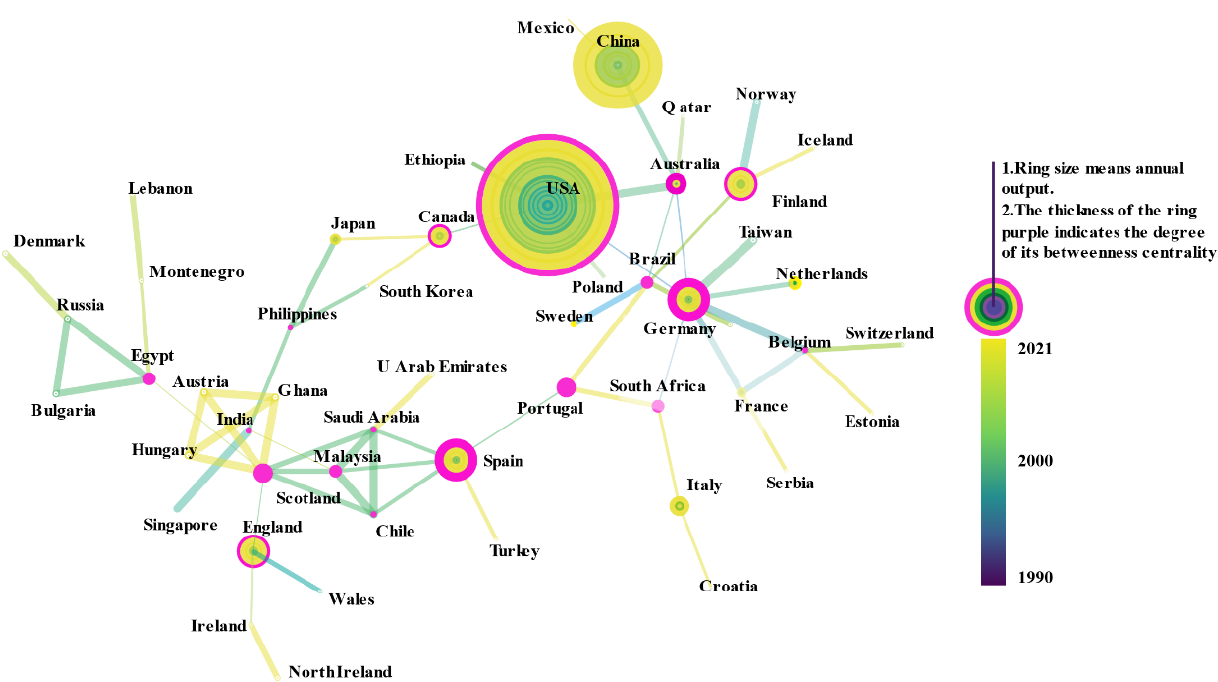
Figure 4. Mapping knowledge domains of coauthoring countries.